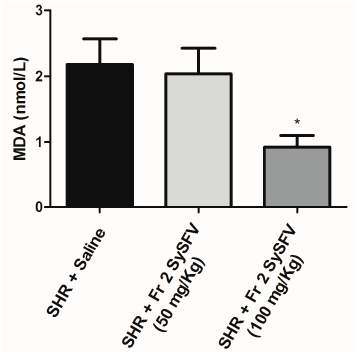
Figure 4. Levels of serum malondialdehyde (MDA) in spontaneously hypertensive rats pre-treated with Fr 2 SySFV for 15 days p.o. at doses of 50 mg/kg and 100 mg/kg and saline-treated controls. * p < 0.05, when compared to SHR + saline group. Values are mean ± SEM., n = 5 for each group.